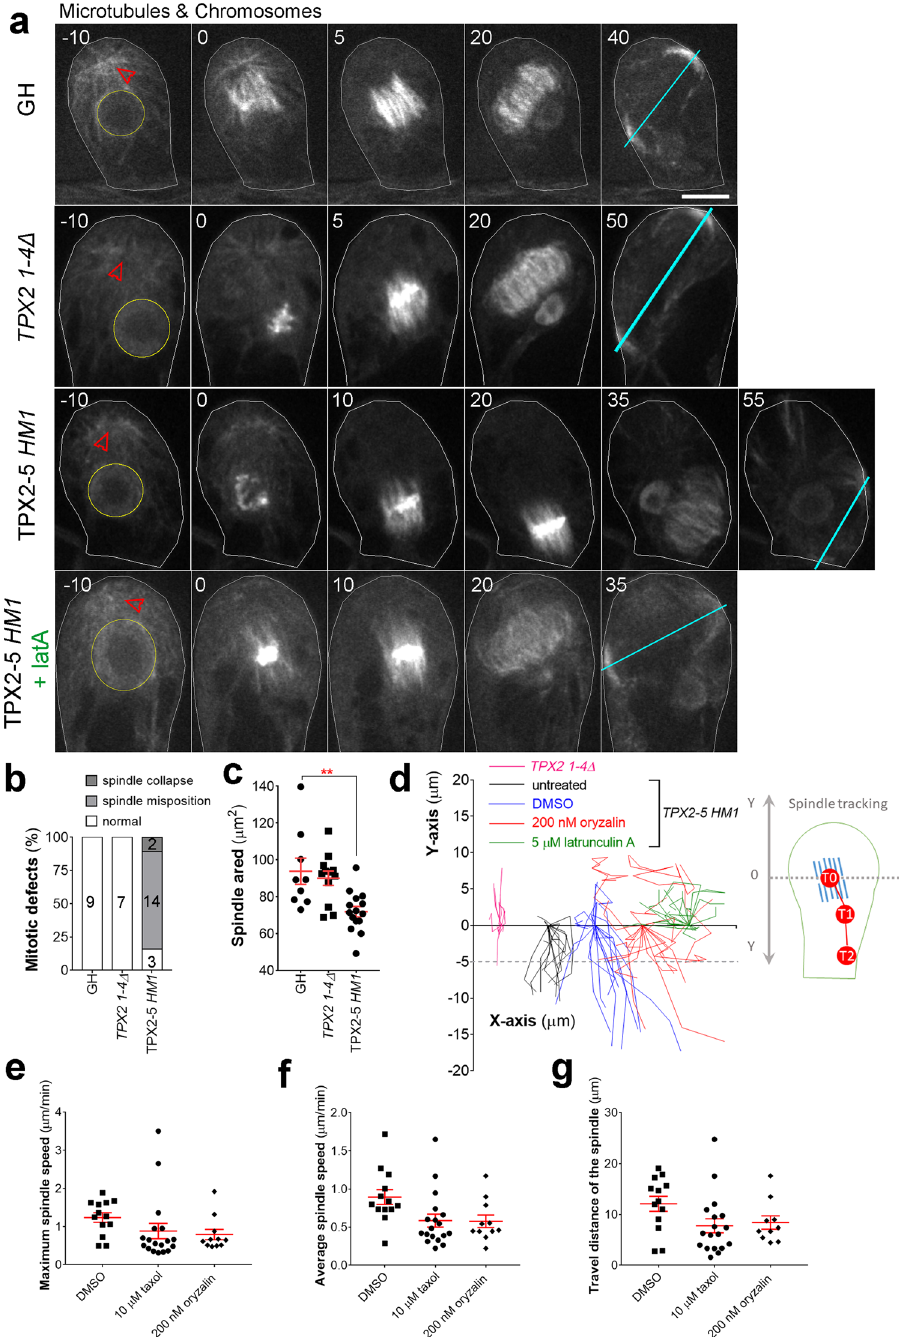
Fig. 5 Spindle position is actively maintained through the interplay between microtubules and F-actin. a Live-cell imaging of the fi rst asymmetric division in the gametophore initial. The positions of the nucleus and gametosome (prophase MTOC appeared in the apical cytoplasm) are indicated with yellow circles and red arrowheads, respectively. Cyan lines show the position and orientation of the phragmoplast. Cell borders are outlined with white lines. Live-cell imagining was repeated three times with similar results. Bar, 10 µ m. b The frequency and type of spindle defects in gametophore initial mitosis observed in GH (control), TPX2 1-4 Δ , and TPX2-5 HM1 lines. Numbers within the columns indicate number of cells with corresponding phenotypes. c Area occupied by the metaphase spindle (spindle size) in gametophore initials measured by manually tracking spindle borders from Z-projection, n = 9, 12, and 15 for GH, TPX2 1-4 Δ and TPX2-5 HM1 lines, respectively. (mean ± SEM; ** p = 0.0029, two-tailed Student ’ s t-test). d Tracking of the spindle center position from NEBD to anaphase onset. We assigned the starting position as Y = 0 and different X positions for each sample group. Note, that after 5 µ M latrunculin A treatment, spindles never showed motility towards the basal end of the cell, i.e., negative Y -values. Each line represents spindle movement in a single cell. More than 12 cells were observed for each sample group in three or more independent experiments. e Maximum spindle speed ( µ m/min), f average spindle speed ( µ m/min), and g distance traveled by the spindle ( µ m) in the TPX2-5 HM1 cell line under various treatments. Total number of cells observed, including those without spindle motility: n = 23 (10 µ M taxol), 16 (200 nM oryzalin), and 20 (control DMSO, with which the stock solution of taxol, oryzalin, and latrunculin A were prepared). Only spindle motility towards the basal end of the cell was analyzed. Bars represent mean ± SEM.